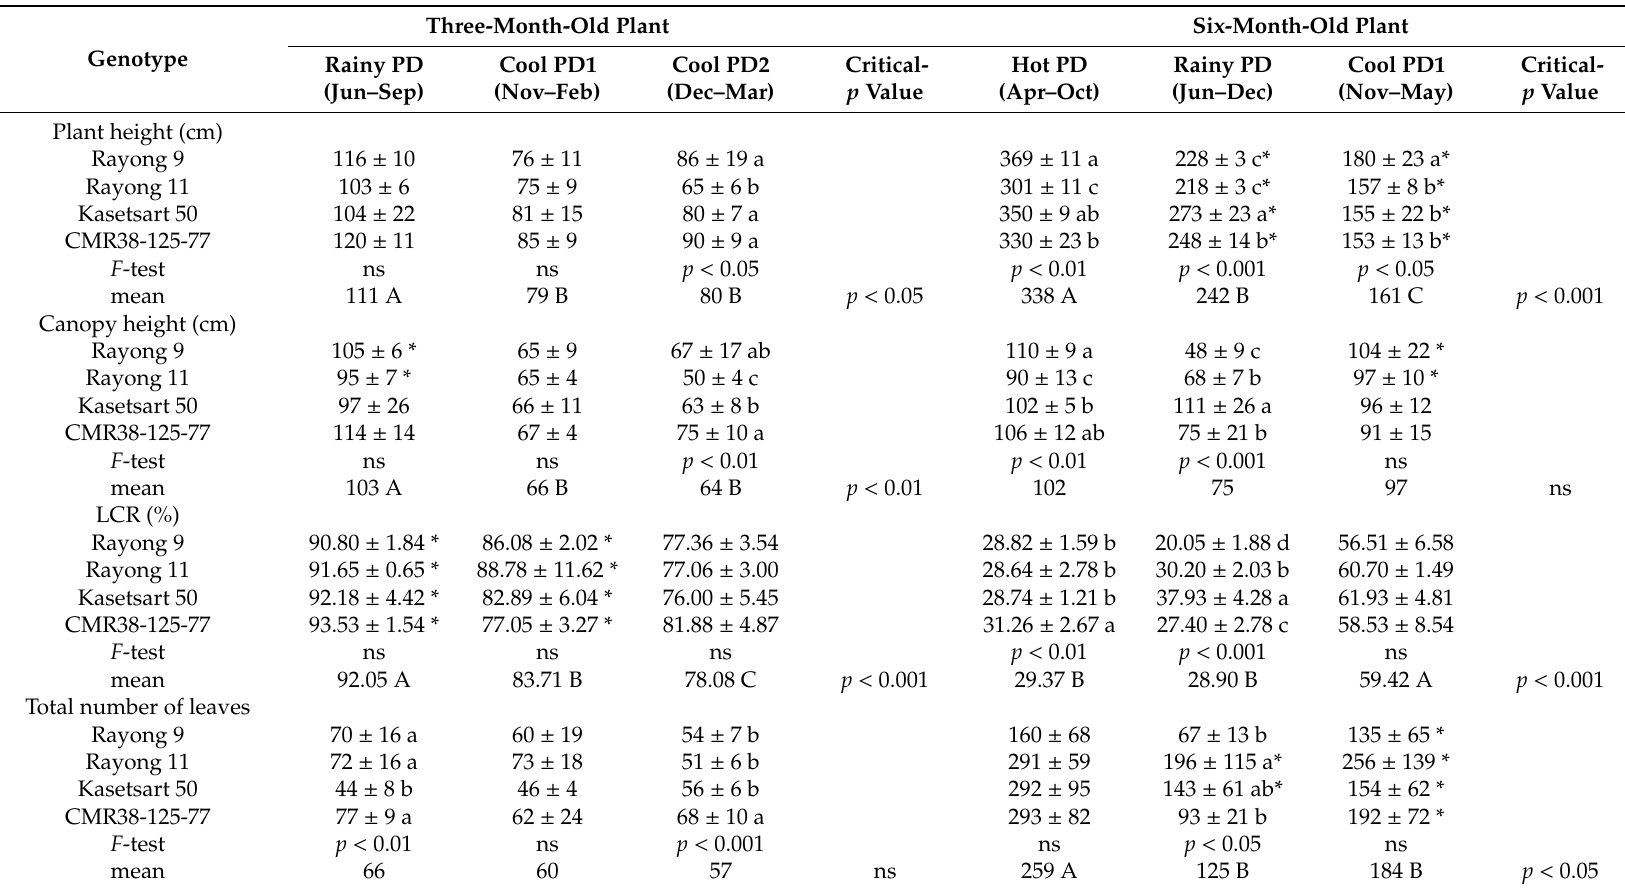
Table 1. Canopy traits including plant height, canopy height, live crown ratio (LCR), total number of leaves, internode length, and leaf area index (LAI) of cassava Rayong 9, Rayong 11, Kasetsart 50, and CMR38-125-77 planted in April (Hot PD), June (Rainy PD), November (Cool PD1), and December (Cool PD2) in 2015. The e ff ects of planting dates (PD) on canopy structure were investigated in the 3- and 6-month-old plants. Means ± SD were from 6 six plants (two plants / replication) of each genotype. Means which were significantly di ff erent ( p < 0.05) among genotypes are denoted with di ff erent lower case letters, whereas those among planting dates are represented by di ff erent capital letters. The significant di ff erence ( p < 0.05) between the age of plant (3- and 6-month-old plants) of the same PD are denoted with